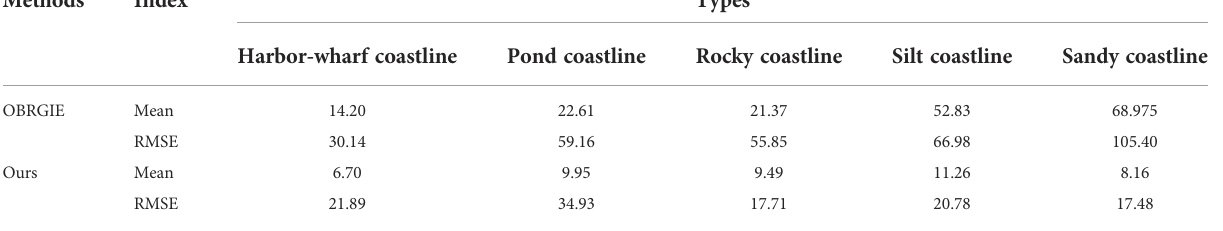
TABLE 7 Position accuracy of coastline types in different methods (unit: